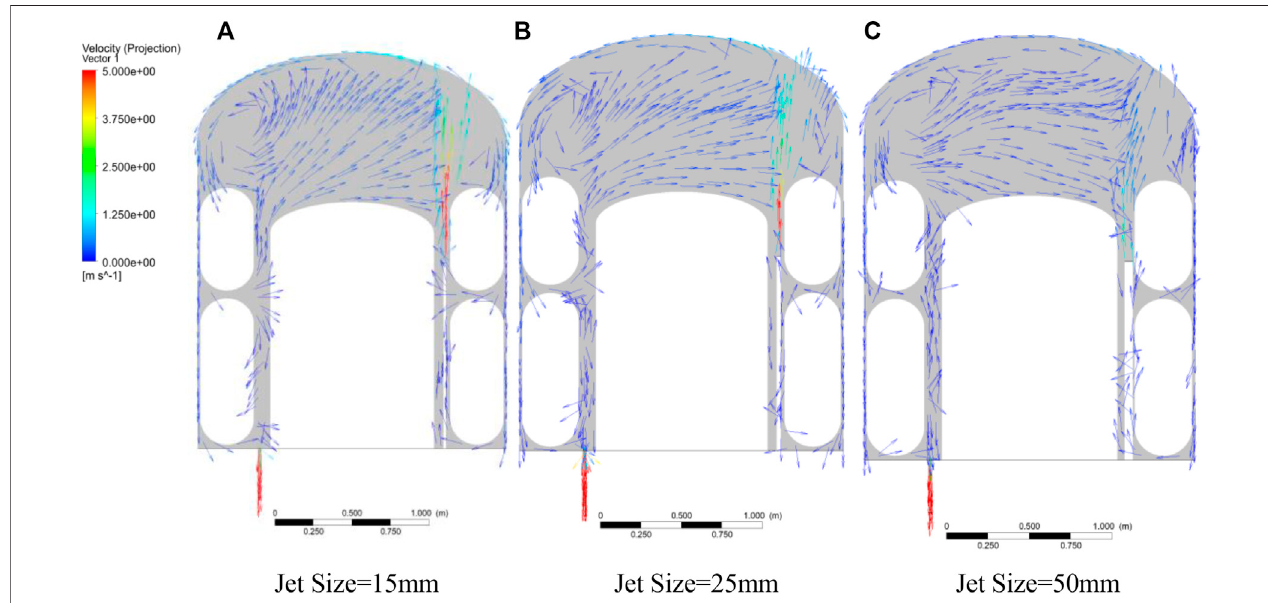
FIGURE 13 | Distribution of velocity vectors in the containment at different jet diameters. (A) Jet size = 15 mm. (B) Jet size = 25 mm. (C) Jet size = 50